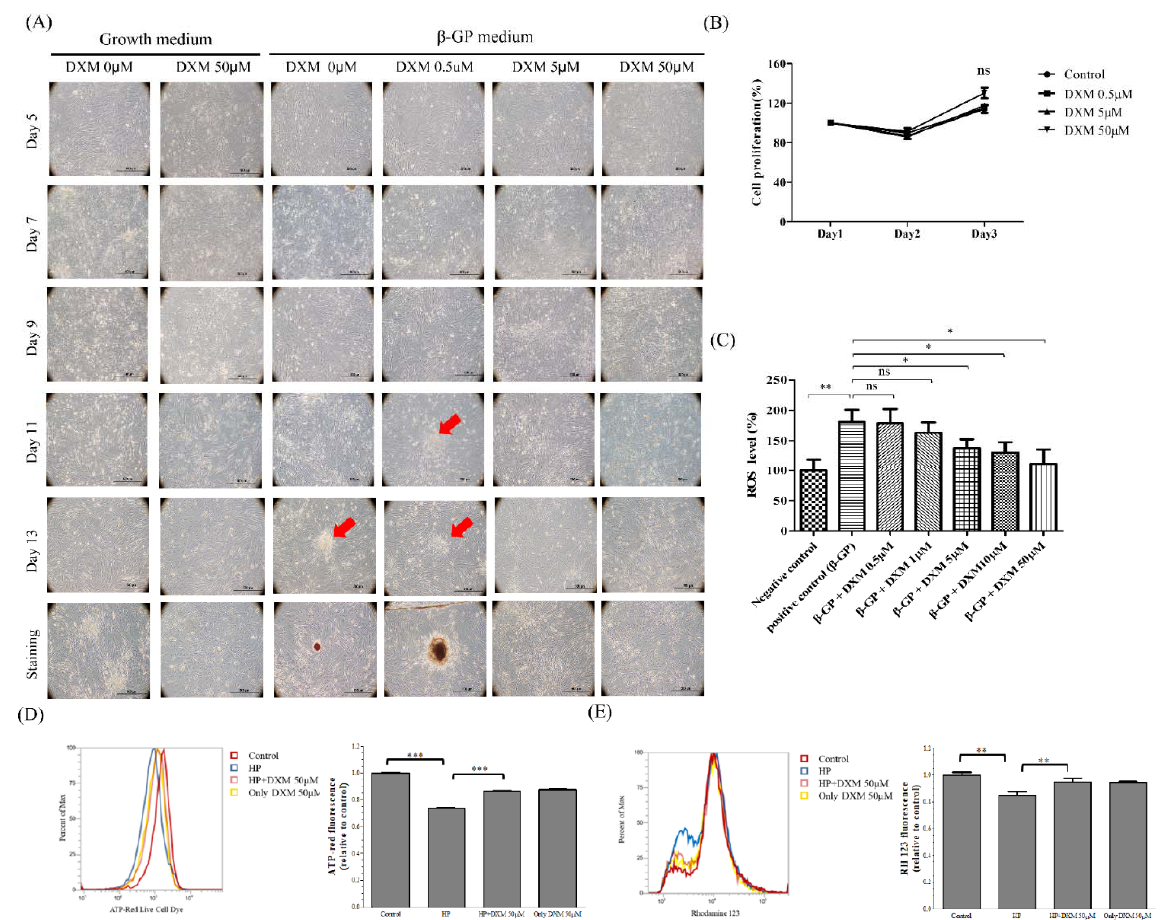
Figure 1. Effect of high-phosphate medium and dextromethorphan (DXM) on calcification of rat smooth vascular cells. ( A ) High-phosphate medium and DXM treatment in rat smooth vascular cells from day 5 to day 13. Cells cultured with high phosphate medium display non-specific mineral deposition (the red arrow). Alizarin red S staining for Ca deposits on day 14. ( B ) Dose-dependent effects of DXM on rat smooth vascular cell viability. ( C ) Dose-dependent effects of DXM on rat smooth vascular cells with high-phosphate medium related oxidative stress. ( D ) ATP generation and ( E ) mitochondria membrane potential (* p < 0.05, ** p < 0.01,*** p < 0.001, no significant difference (ns)). Abbreviations: Beta-glycerophosphate ( β -GP); reactive oxygen species (ROS); high phosphate medium (HP).